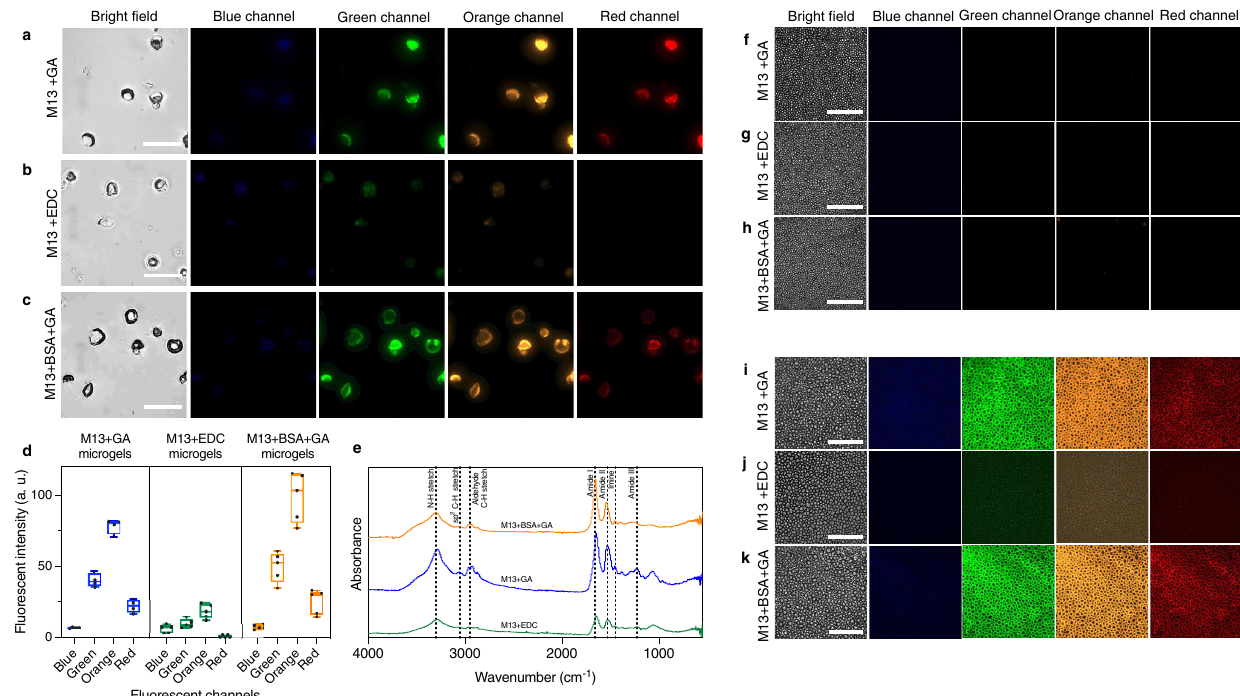
Fig.3|Fluorescencepro fi leofM13phagemicrogelsand fl uorescencepro fi leof thetemplatebefore and afterthe microgelformation. a – c Fluorescent images of three types of phage microgels made of 5×10 13 PFU mL − 1 of M13 phage with a 0.1 M GA, b 0.1 M EDC, and c 2% BSA+0.1M GA. Scale bar: 100 μ m. GA glu- taraldehyde, EDC 1-Ethyl-3-(3-dimethylaminopropyl) carbodiimide, BSA bovine serum albumin. d Quanti fi ed fl uorescent intensity of 3 types phage microgels under four different channels. Box plots show minimum to maximum (whis- kers), 25 – 75% (box), median (band inside) with all data points. a.u. arbitrary unit. M13+GA microgels: n =4 microgels per fl uorescent channel. M13+EDC and M13+BSA+GA microgels: n =5 microgels per fl uorescent channel. e FTIR